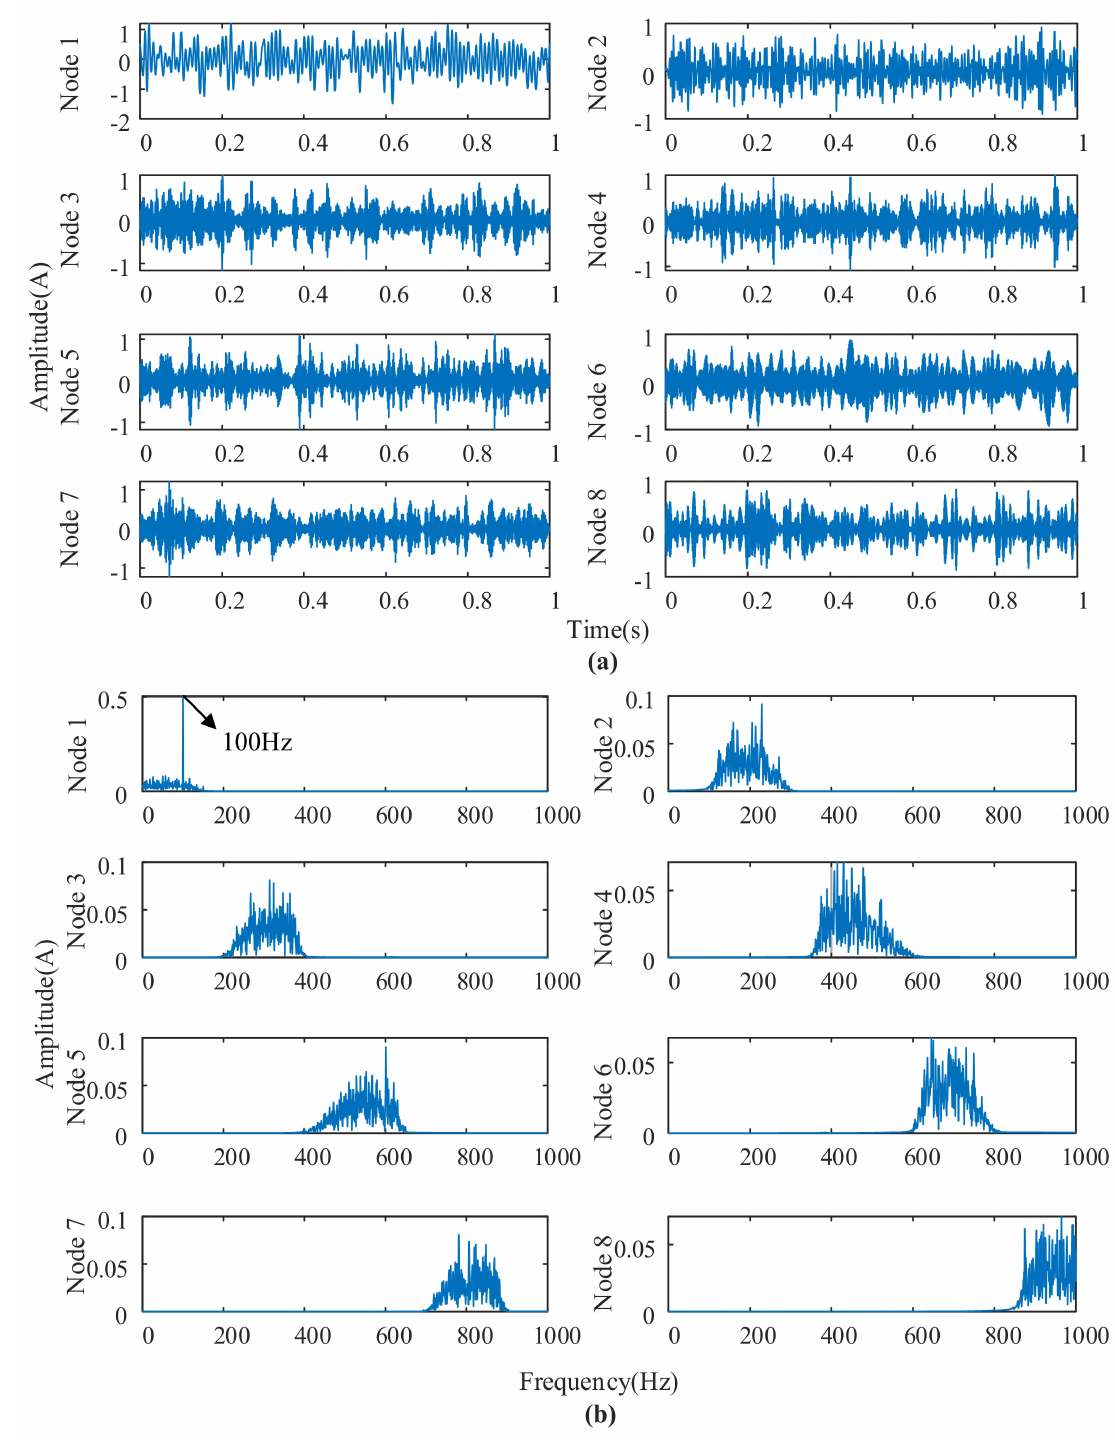
Figure 14. Wavelet packet coefficients of the original signal: ( a ) Time − domain; ( b ) frequency